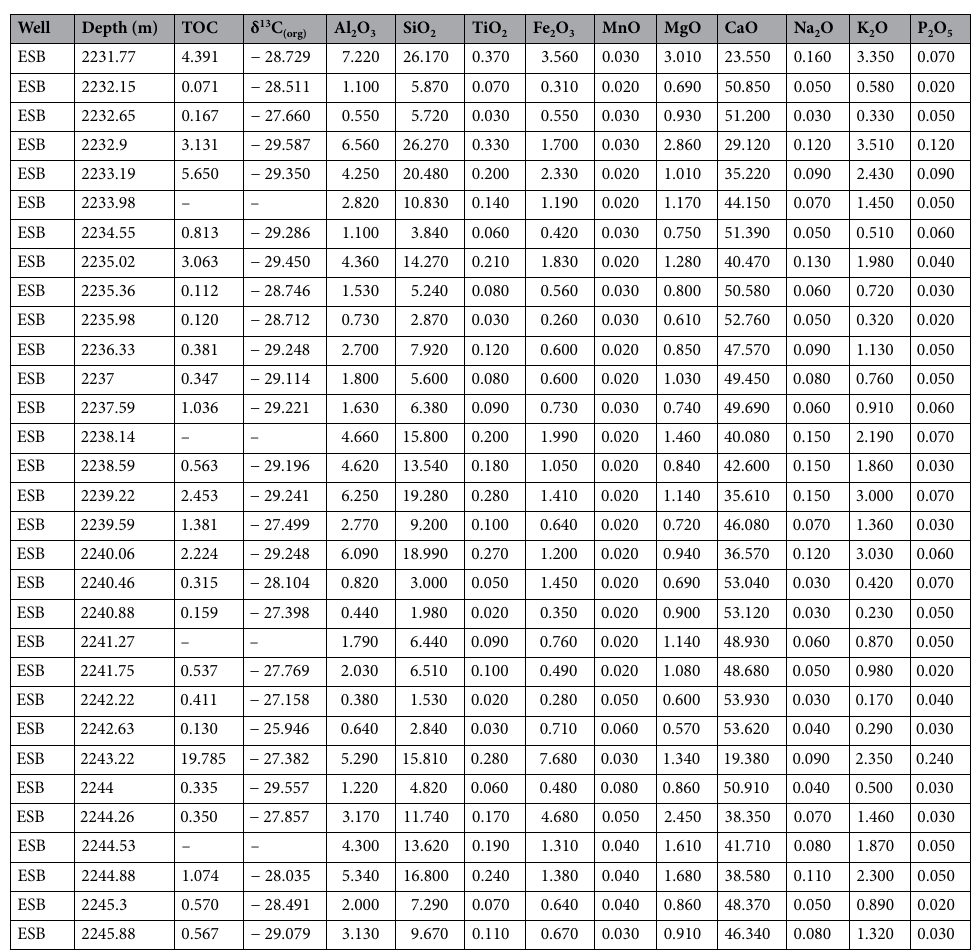
Table 1. δ 13 C (org) reported as ‰ VPDB, total organic carbon (TOC), and oxide data for the Kaybob (K), Willesden Green (WG), and East Shale Basin (ESB)